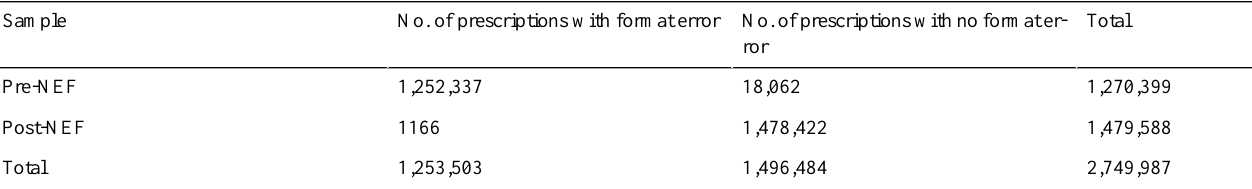
TotalNo. of prescriptions with no format er- rorNo. of prescriptions with format errorSample